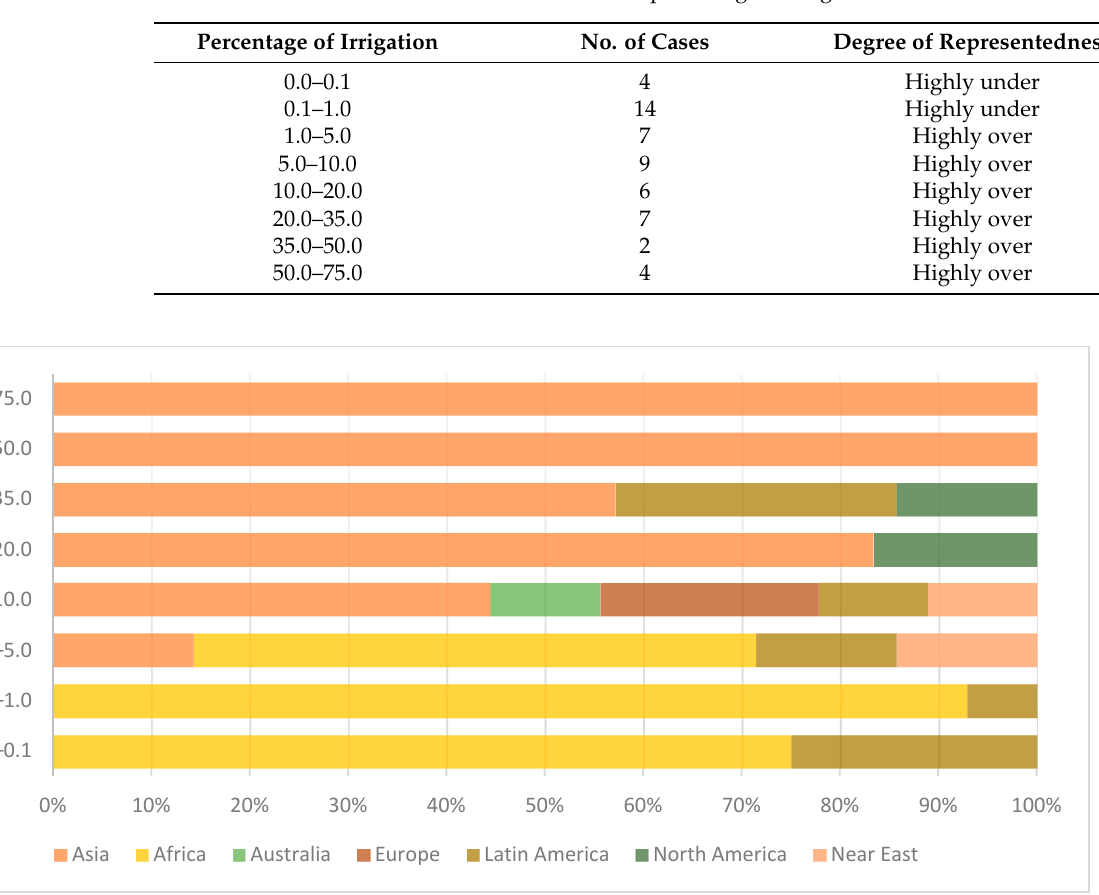
Figure 12. Distribution of study regions based on the percentage of area equipped for irrigation.